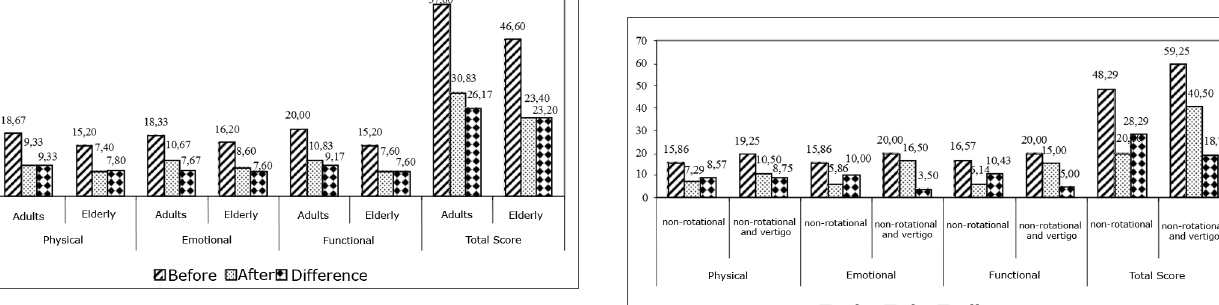
Graphic 5. Comparing subjects with non-rotational dizziness and those with vertigo as to the differences in